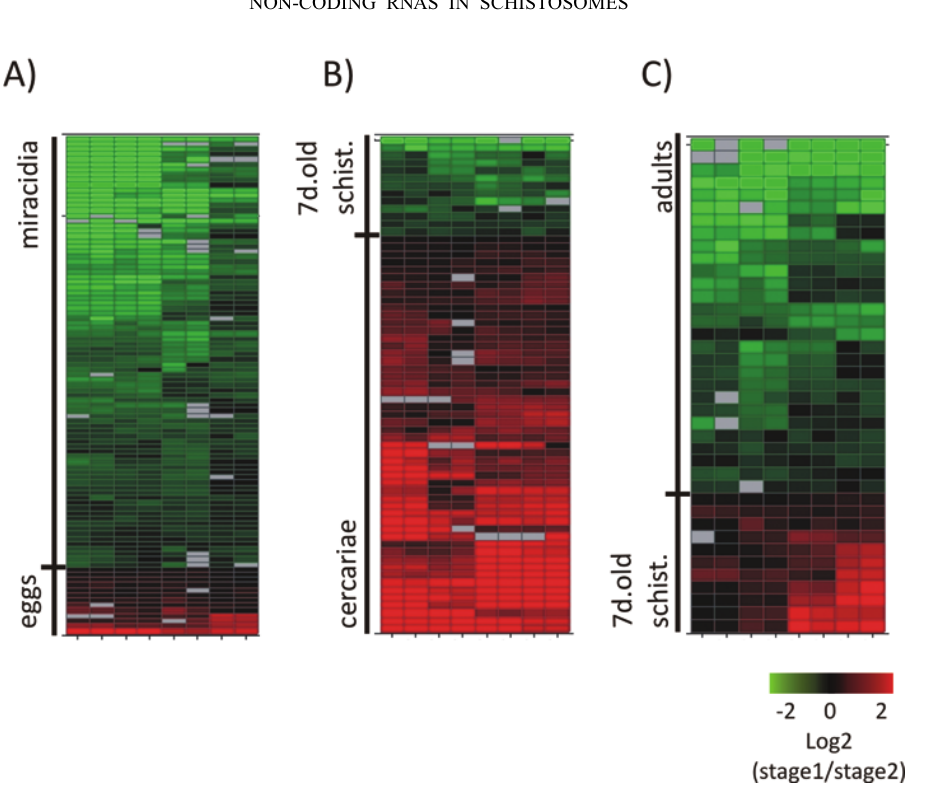
Fig. 4 – Heat map of differential expression of non-protein coding genes between two developmental stages. A) eggs vs. miracidia; B) cercariae vs. 7-day-old schistosomula; C) 7-day-old schistosomula vs. adult worms. Each line represents a gene and each column represents a replica (4 technical replicas for each one of two biological replicas). Color is proportional to expression levels of the gene in a given stage compared to the next, according to the range indicated in the figure insert, and it is calculated as the log2 of the expression ratio in stage 1 (first in the pairwise comparison)/stage 2 (second in the pairwise